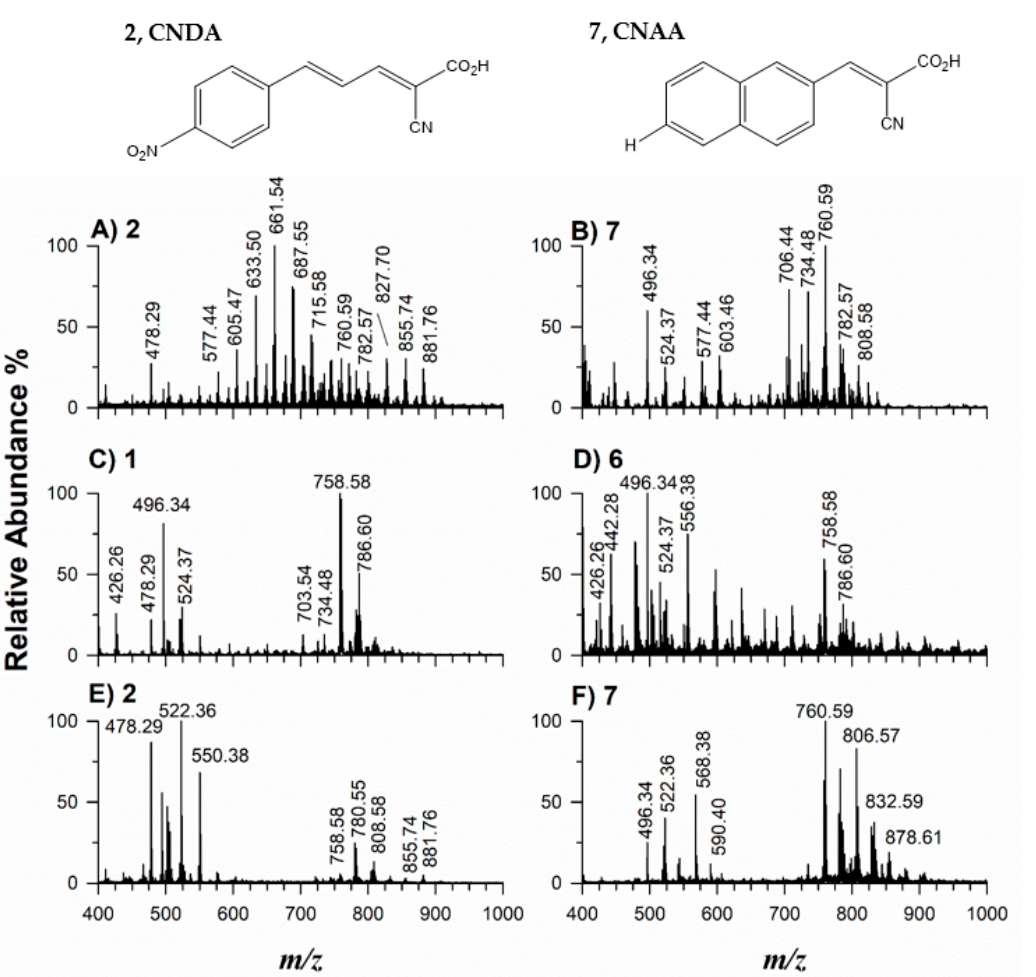
Figure 7. Positive MALDI-ToF MS spectra of the lipid milk extract mixed with matrix 2 ( A ) and 7 ( B ), blood lipids mixed with matrix 1 ( C ) and 6 ( D ), human plasma sample mixed with matrix 2 ( E ), and fish fillet extract blended with matrix 7 ( F ). The structures of best matrices 2 and 7 are reported on the top.